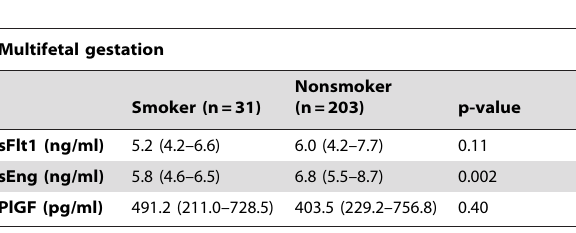
Table 5. Comparison of angiogenic factors in women with multifetal gestations: smokers versus nonsmokers.*